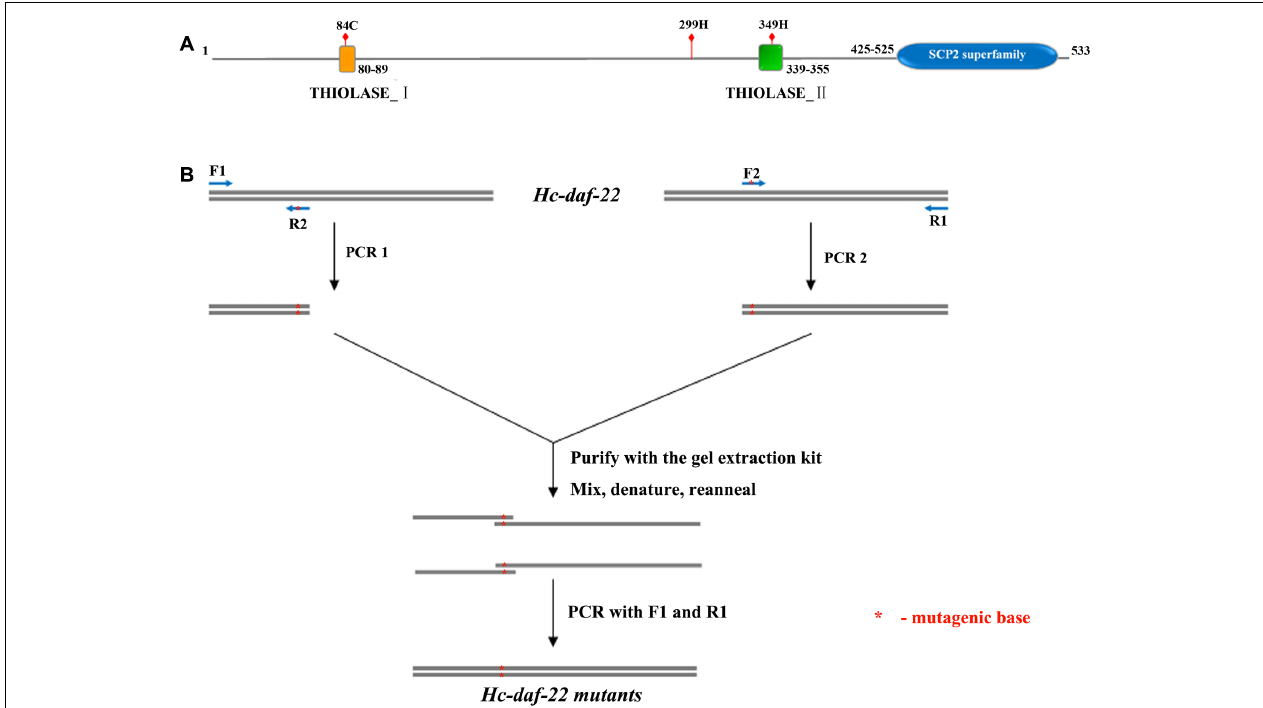
FIGURE 1 | Possible functional sites prediction and site-directed mutagenesis. (A) Schematic diagram of Hc-DAF-22 illustrating possible functional sites, conserved domain and motifs; (B) detailed representation of introducing site-directed mutagenesis into Hc-daf-22.